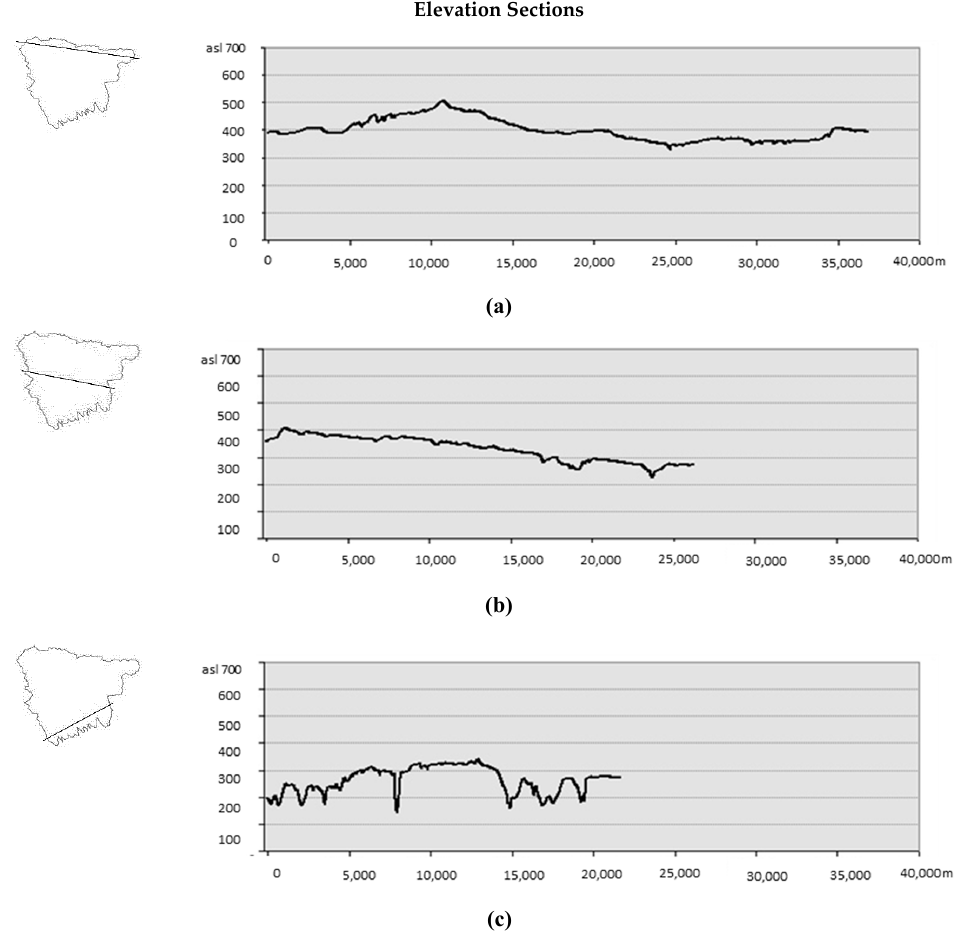
Figure 2. Elevation sections of the study area from northern ( a ), central ( b ), and southern ( c ) zones. The present study was based on 67 AAPs captured in black and white between 1954 and 1955 during the first Italian National Planimetric Survey. The photographs (23 cm x 23 cm) were taken with metric cameras at a height of 6000 m with an acquisition scale of 1:34,000. The analogue AAPs were digitalized by means of an Epson Expression 1640 XL nonphotogrammetric scanner with a resolution of 800 dpi (or equivalently, 31.75 µm). AAPs were purchased already digitalized from the IAGO/IGM retailer (Italian Army Geographical Office/Istituto Geografico Militare). Scanned images had different orientations relative to the original images, and they had an overlap of approximately 60%. Furthermore, a digital terrain model (DTM) was obtained by merging DTMs of Apulian and Basilicata regions, which have a resolution of 8 m and 5 m, respectively. Digital orthoimages of the 2016 flight for the Puglia region and that of 2013 for the Basilicata region were used. The two orthophotographs have a scale of 1:5000 with a 50 cm pixel resolution. 3. Materials and Methods 3.1. Methodology The proposed workflow can be divided into three main steps (Figure 3): (i) orthomosaic production and GCP selection; (ii) absolute orthoimage orientation and GCPs’ coordinates error assessment; and (iii) spatial analysis and error map production. Orthomosaic production is described in Section 3.1.1, and GCP selection is outlined in Section 3.1.2. Variables considered for the improvement of the final orthomosaic accuracy (Section 3.1.3) are the coordinate errors along the X and Y directions that were subjected to spatial analysis (Section 3.1.4). Figure 3. Methodology workflow. GCP, ground control point; RMSE, root mean square error. In conclusion, by analyzing the obtained error maps, areas overcoming a given user-threshold are sought (Section 3.1.4). If these areas are found, the GCP number is then increased (Section 3.1.5); otherwise, the final fine georeferenced orthomosaic is gained.